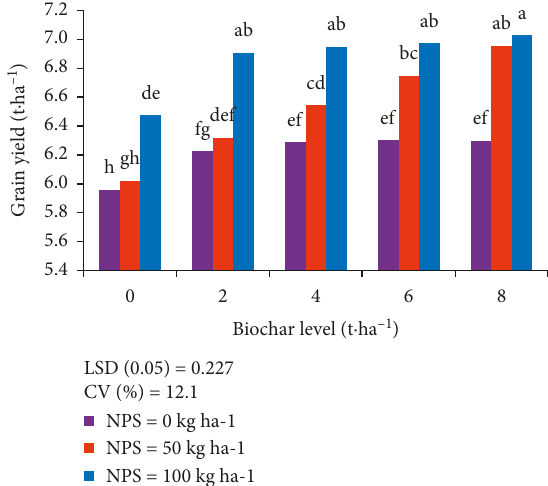
Figure 1: Effect of levels of biochar and NPS fertilizer rates on maize grain yield (t · ha − 1